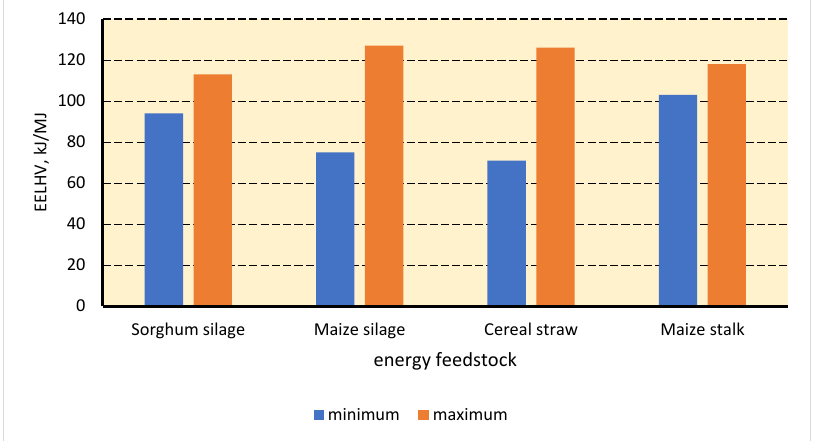
Figure 3. Embodied energy per lower heating value.